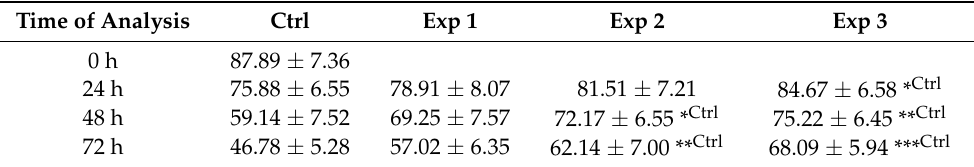
Table 2. Viability of boar spermatozoa (%) exposed to selected semen extenders during different time intervals.